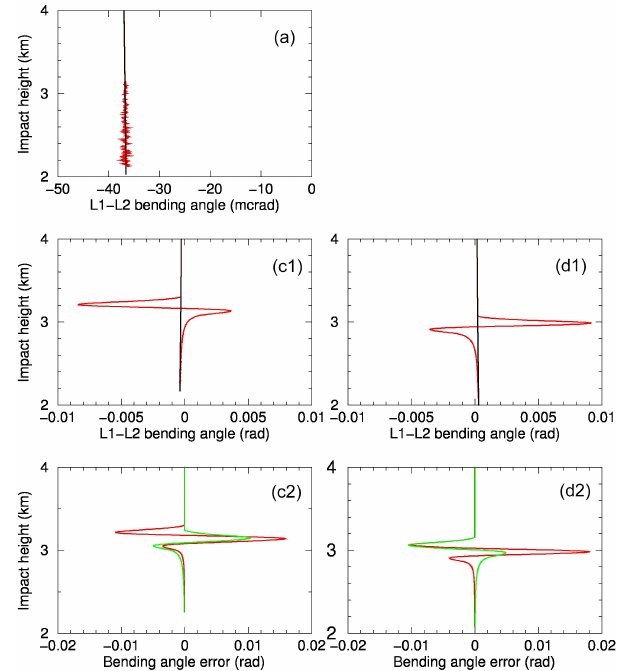
Figure A5. The α 1 (h) − α 2 (h) for spherically symmetric (a) and non-spherically symmetric (c1, d1) ionospheric refractivity, for the exponential atmospheric refractivity (black lines) and with added inversion layer (red lines). The errors of the ionospheric correction (c2, d2) in the presence of the inversion layer and horizontally in- homogeneous ionosphere: the standard correction (red lines) and correction by extrapolation (green